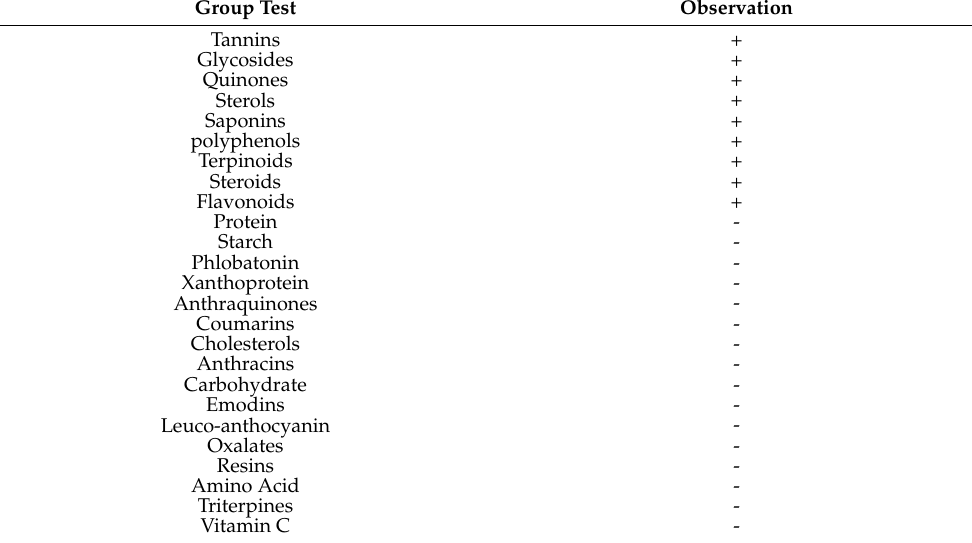
Table 1. Phytochemical screening of the methanol extract of Bauhinia scandens stems. Group